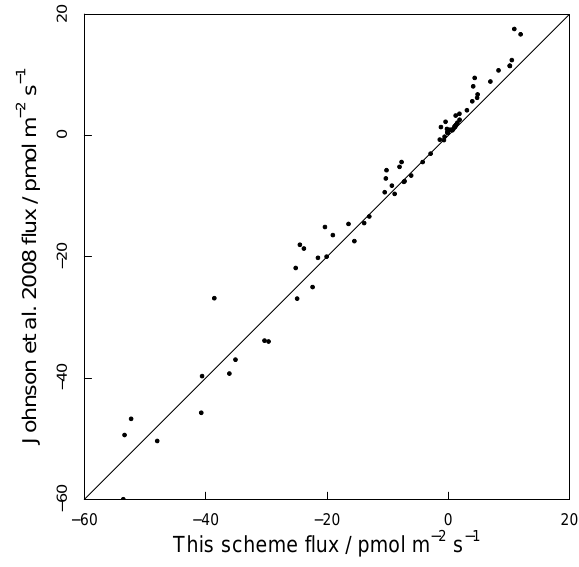
Fig. 8. Comparison of the NH 3 ocean-atmosphere fluxes from mea- sured data as calculated by Johnson et al. (2008) and using the scheme presented in this